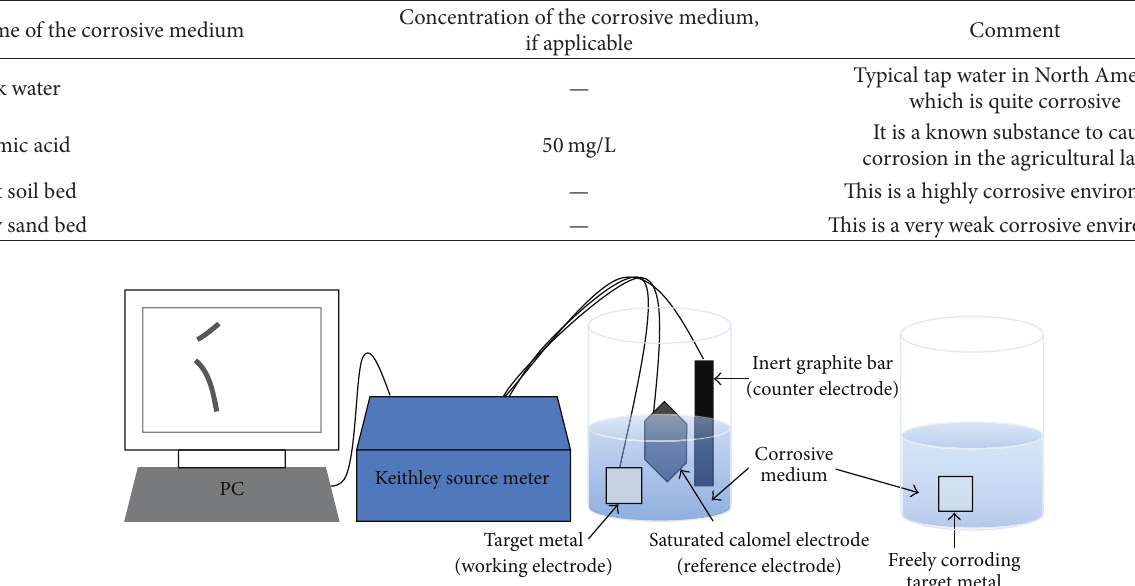
Table 1: Different corrosive mediums used for the validation of the proposed ACPS. The concentrations of the corrosive mediums if they are important and the importance of each corrosive medium are also described.